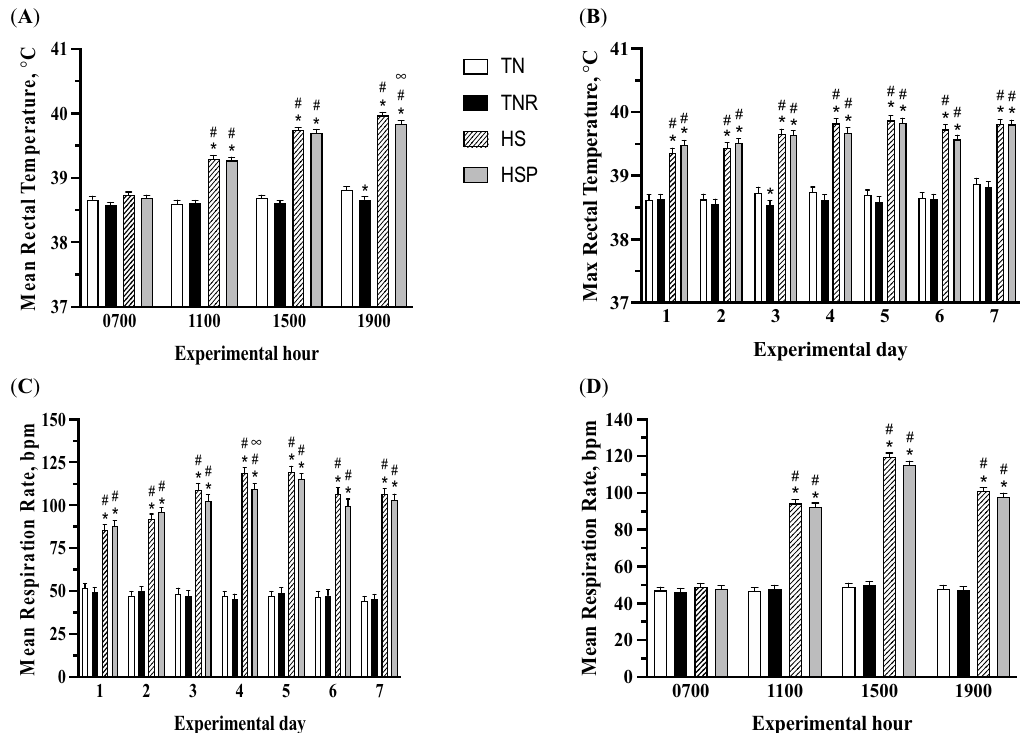
Figure 1. Mean ( A ) and maximum ( B ) rectal temperature of Holstein bull calves. Results denote least squares means + standard error of the mean ( TN thermoneutral, TNR thermoneutral feed-restricted, HS heat stress, HSP heat stress and dietary supplementation with 3 g of AO postbiotic; n = 8 per treatment). P ≤ 0.01 denoted by *(compared against TN), # (compared against TNR), or ∞ (compared against HS). ( A ) Mean rectal temperature in HSP treatment differs compared with TN, TNR, or HS; treatment by h interaction ( P < 0.001). Mean rectal temperature in TNR treatment differs compared with TN. ( B ) Maximal rectal temperature of HS and HSP treatments differ compared with TN and TNR. Mean respiration rate ( C ) of HS and HSP treatments differ compared with TN and TNR; treatment by day interaction ( P < 0.001). Mean respiration rate ( D ) of HS and HSP treatments differ compared with TN and TNR; treatment by day interaction ( P <